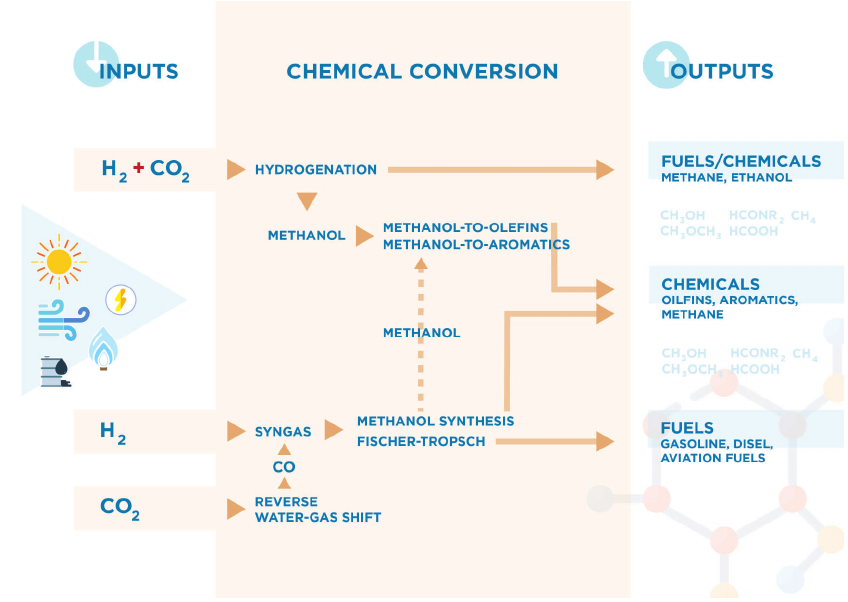
Figure 5. Cluster of CO 2 -H 2